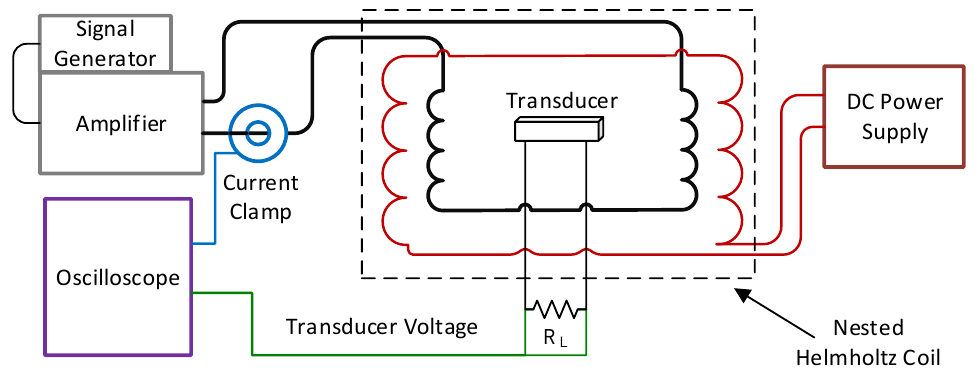
Figure 8. Magnetoelectric transducer experimental test setup diagram.